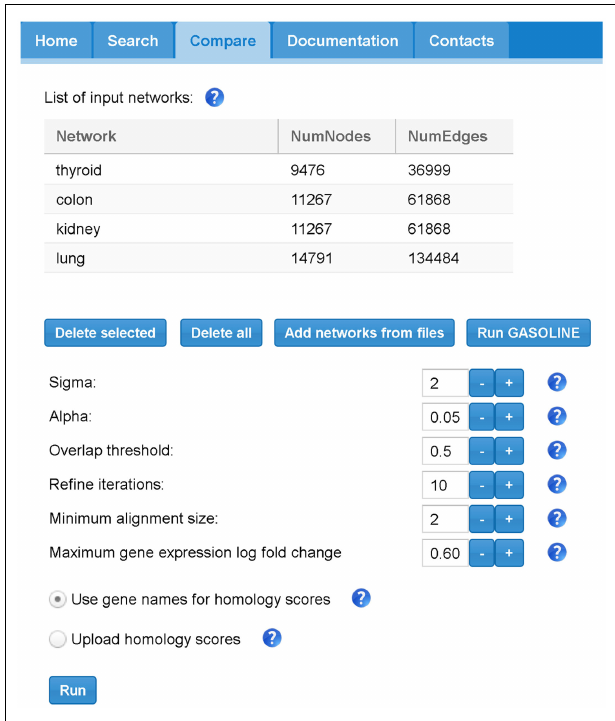
FIGURE 8 | The SPECTRA compare panel . In this example, we first loaded 4 different TS-PPI networks from files using the “Add networks” button. Then by clicking on “Run Gasoline” the form for the selection of the adapted GASOLINE input parameters appears.